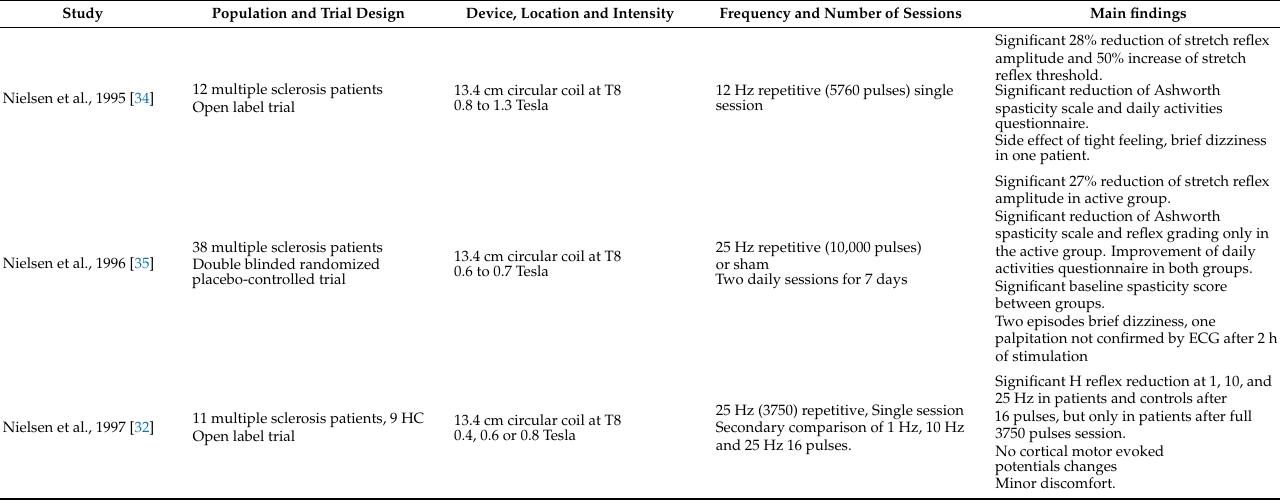
Table 1. Studies investigating clinical applications of